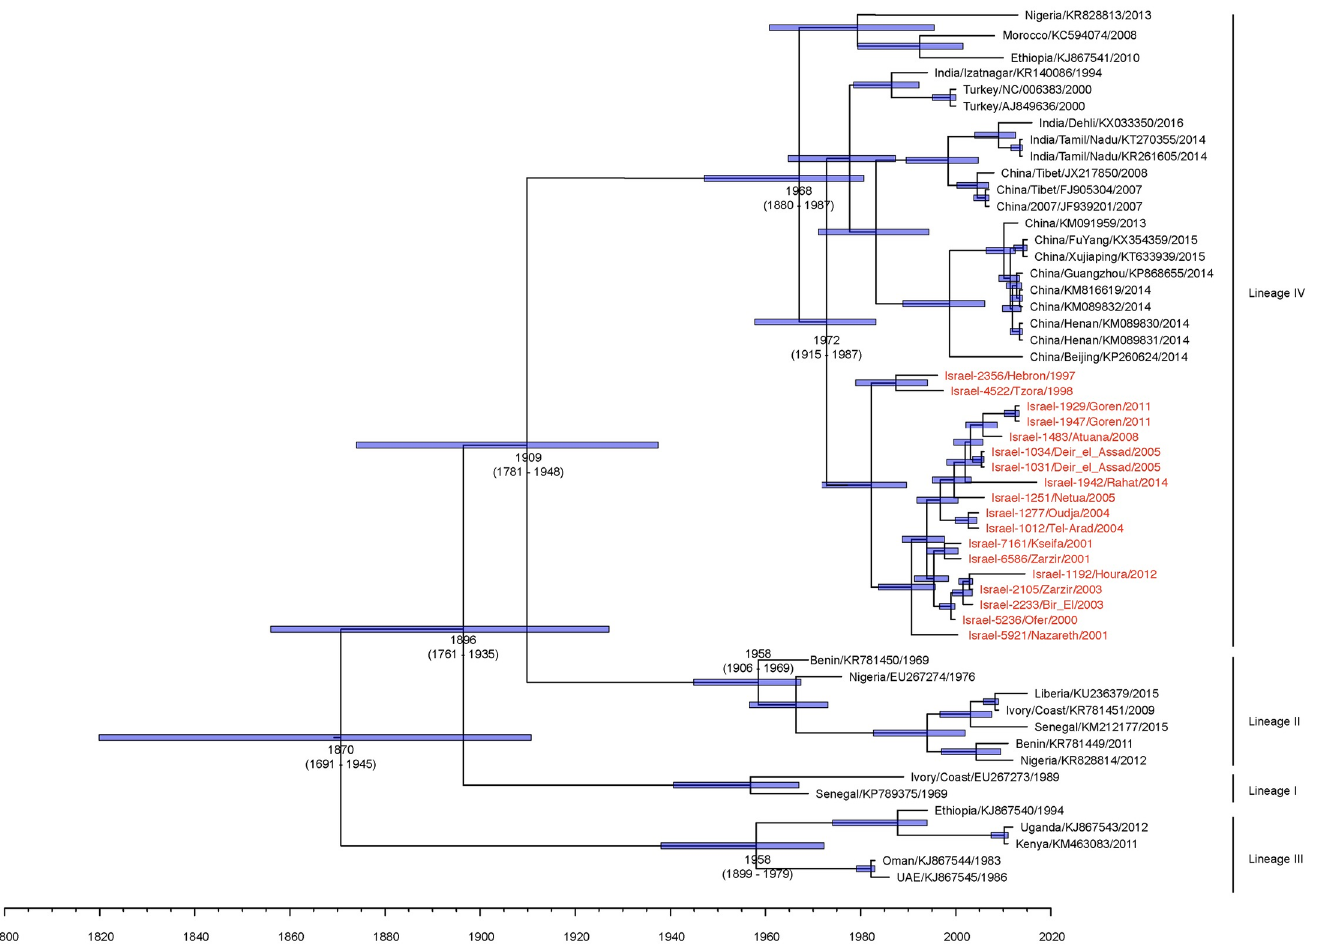
Fig 3. Maximum clade credibility (MCC) tree from Bayesiananalysis of full-length PPRV genomes. The posterior probabilities are indicatedby the size of the node, and TMRCA and 95% HPD of the branches are depicted.Accession number, country of origin, and samplingyear of each isolateis shown. All sequencesgeneratedin this study are highlightedin